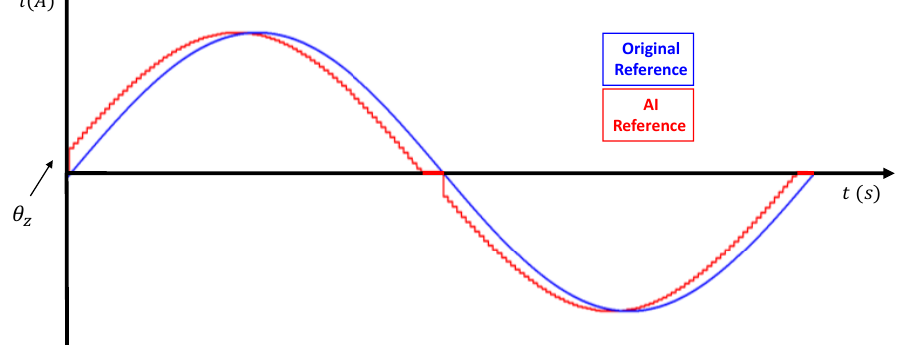
Figure 6. AFDPCF NDZ as a project criterion: ( a ) AFDPCF mapping for different values of c f ( b ) mathematical relation Q f versus c f